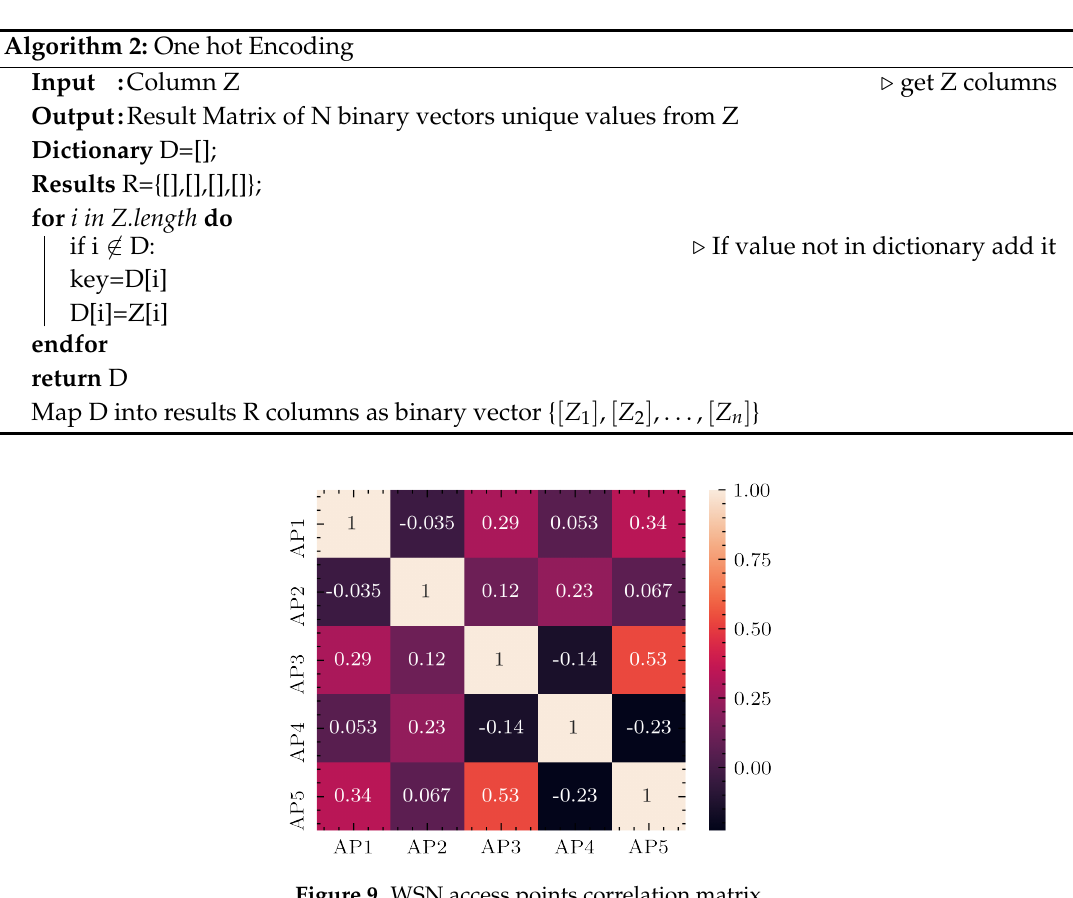
Figure 9. WSN access points correlation matrix.